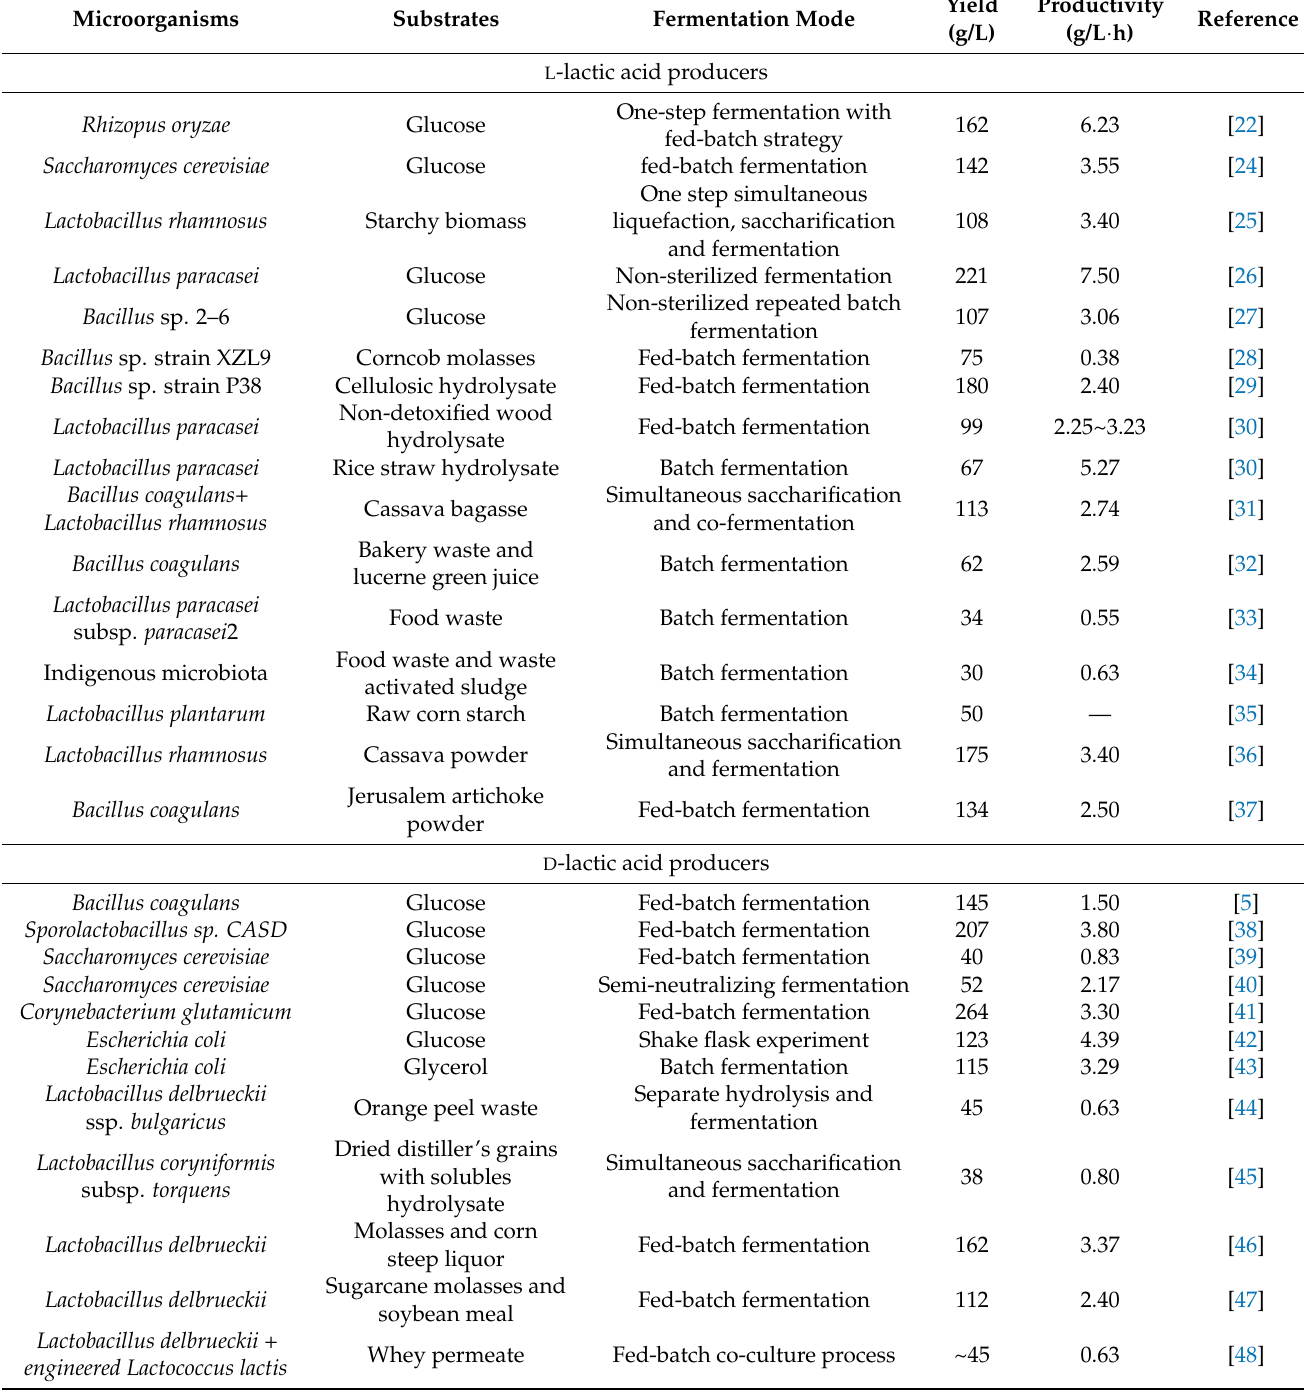
Table 1. Lactic acid production in